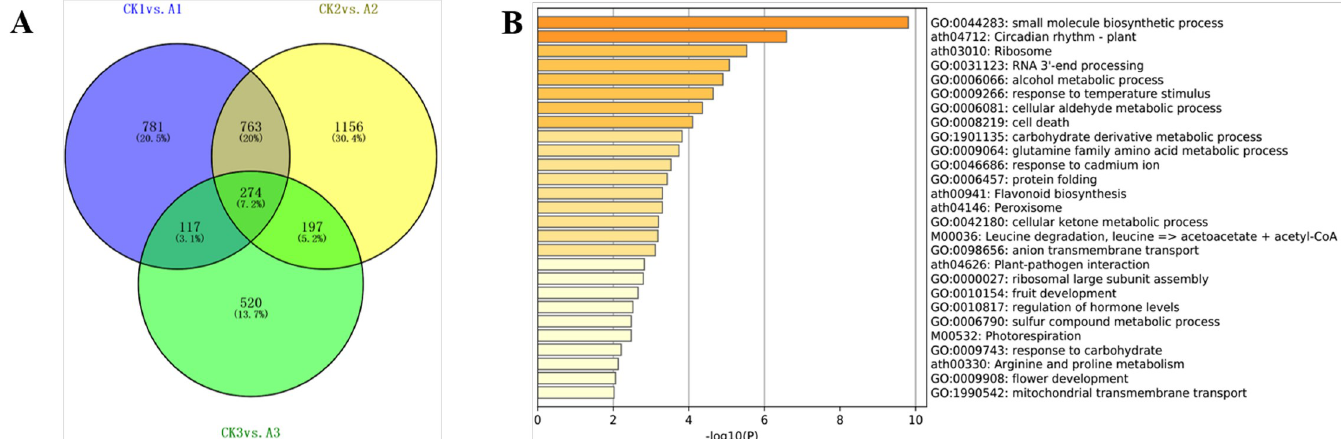
Fig 3. Venn diagram and cluster analyses of DEGs in CK1 vs A1, CK2 vs A2, and CK3 vsA3. (A) Venn diagram showing the overlapped DEGs in three comparison groups; (B) Bargraph of enriched top GO-term and KEGG pathways of co-DEGs, colored by